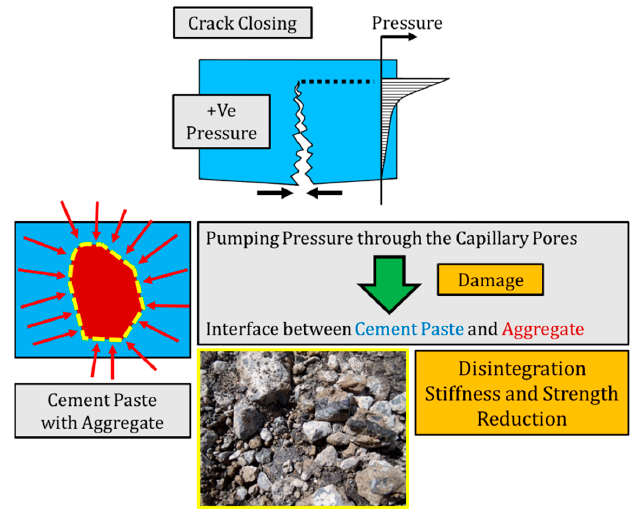
Figure 21. Mechanisms of disintegration of concrete under high cycle fatigue.